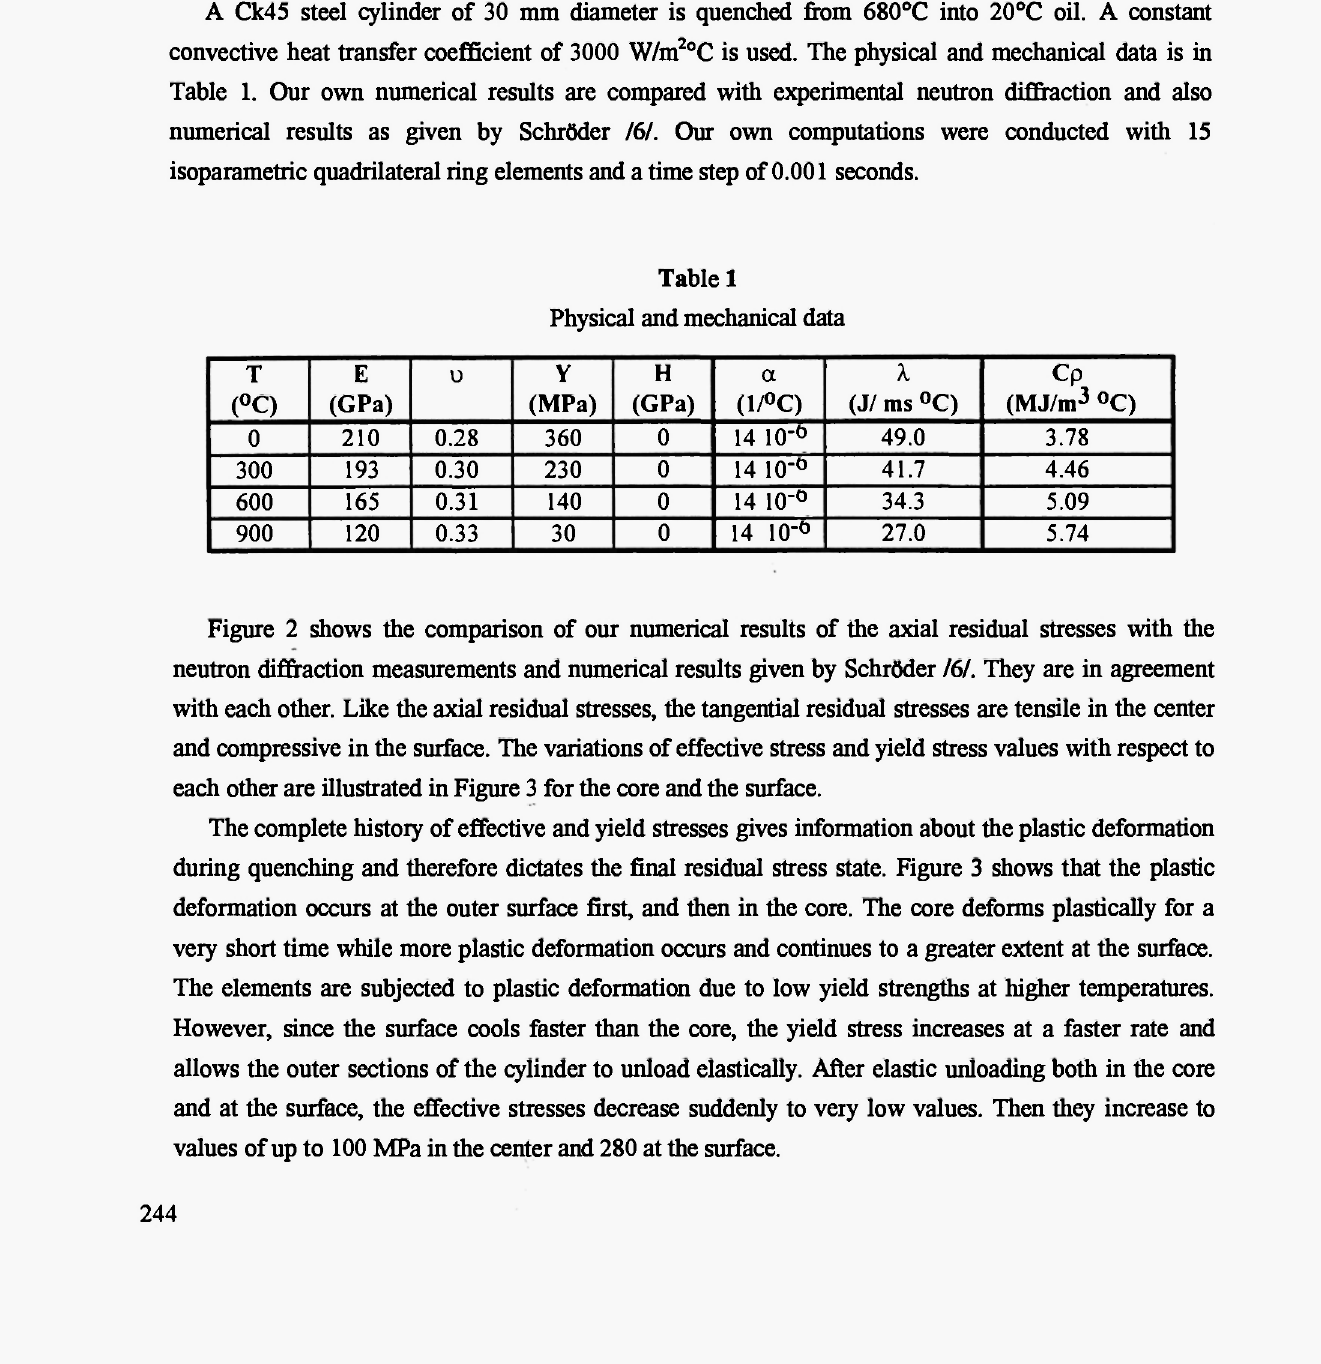
Table 1. Our own numerical results are compared with experimental neutron diffraction and also numerical results as given by Schröder 161. Our own computations were conducted with 15 isoparametric quadrilateral ring elements and a time step of 0.001 seconds.